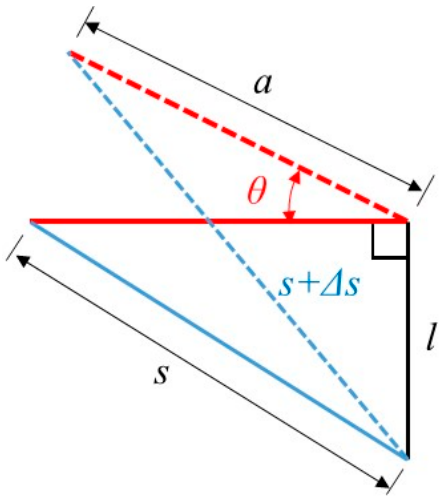
Figure 9. Simplified geometry to derive the stroke of the linear motor for the angle θ .